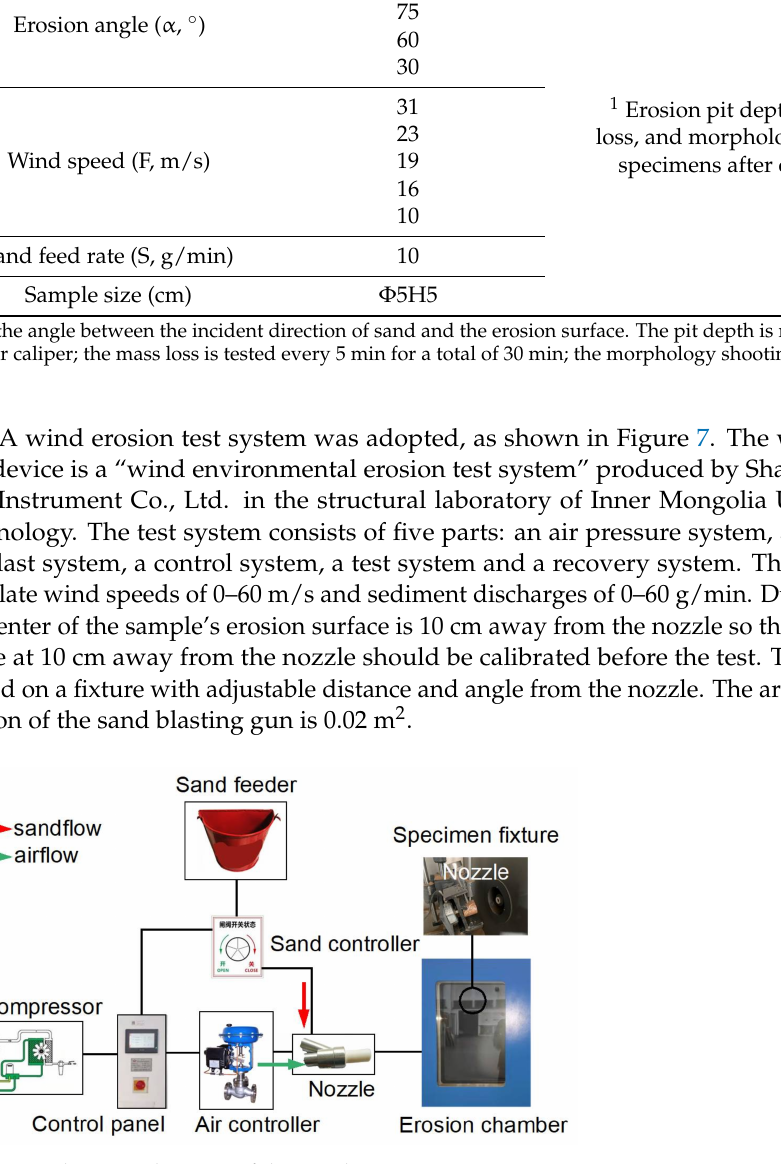
Figure 7. Schematic diagram of the wind erosion test